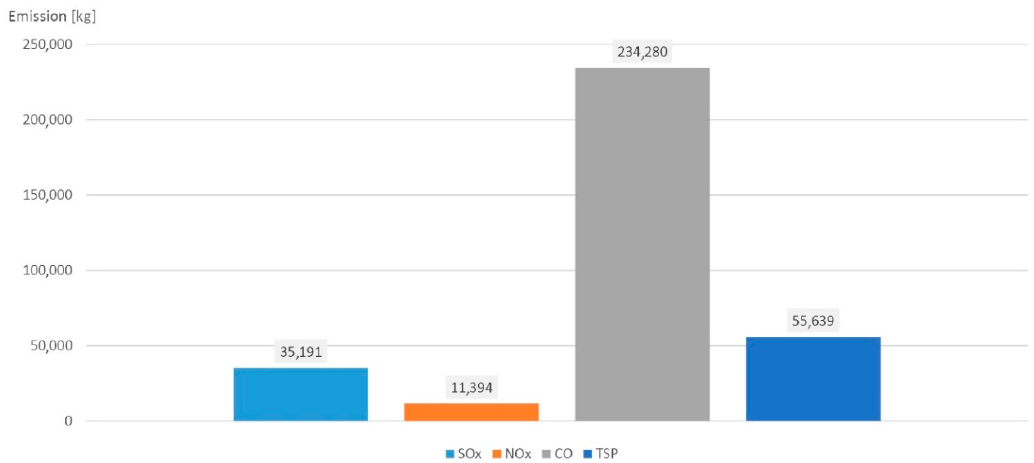
Figure 7. Annual emissions of pollutants in the baseline scenario (Model 1): 70% coal, 25% biomass, 5% fuel oil.